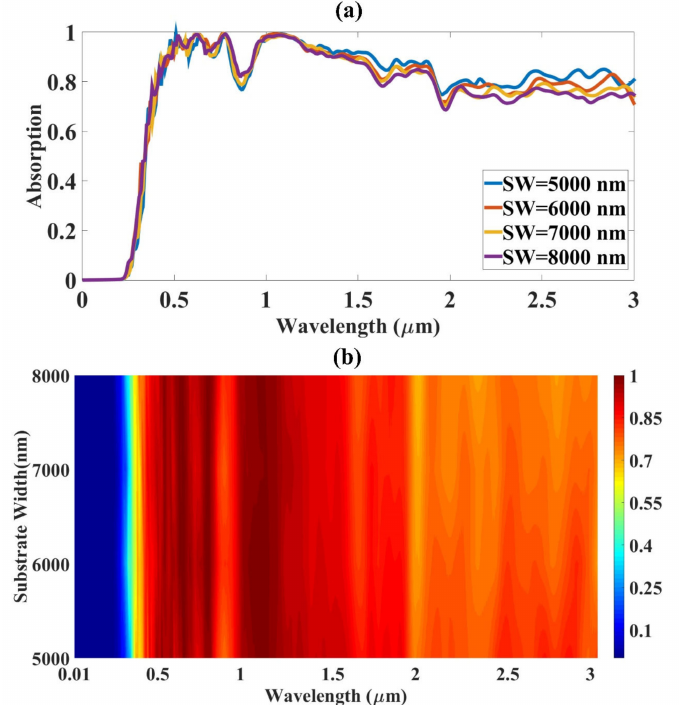
Figure 6. Absorption response for variation in SW (substrate width). The variation is carried out from 5000 nm to 8000 nm with a separation of 1000 nm. The absorption spectrum is presented in the form of ( a ) line, ( b ) color plots for 0 to 3000